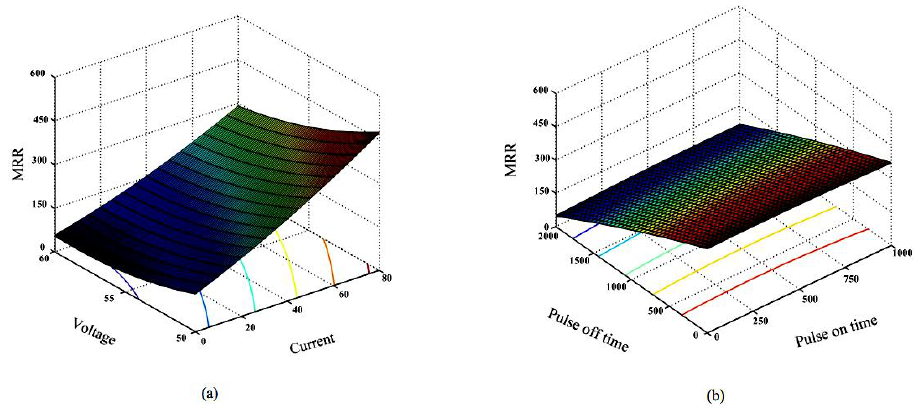
Table 8. New position of particles after the first